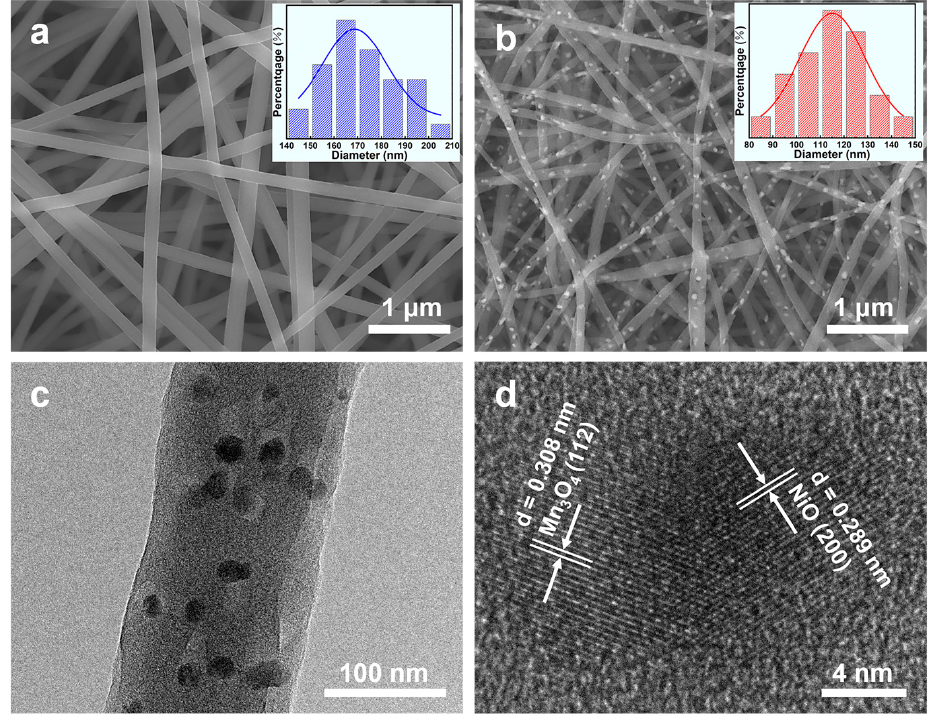
Figure 3. SEM images of electrospun: ( a ) Mn(Ac) 2 /Ni(Ac) 2 /PAN nanofibers and ( b ) Mn 3 O 4 /NiO/CNFs; ( c ) TEM image of Mn 3 O 4 /NiO/CNFs; ( d ) HRTEM image of Mn 3 O 4